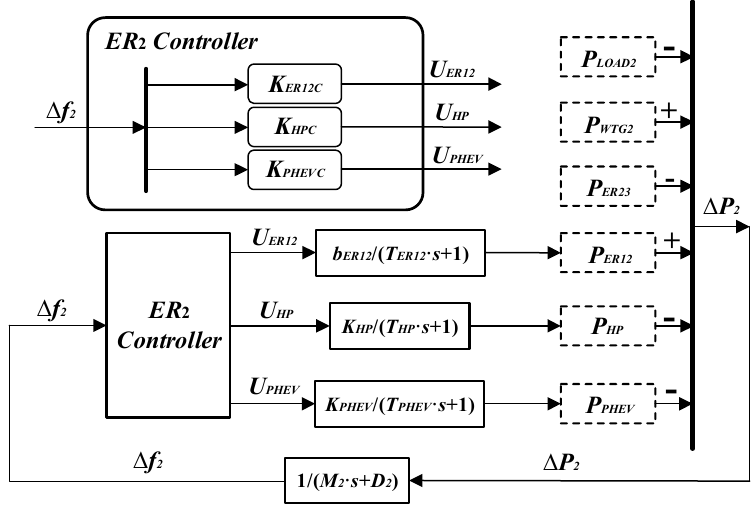
Figure 3. The linearized block diagram of the second microgrid (MG 2 ).